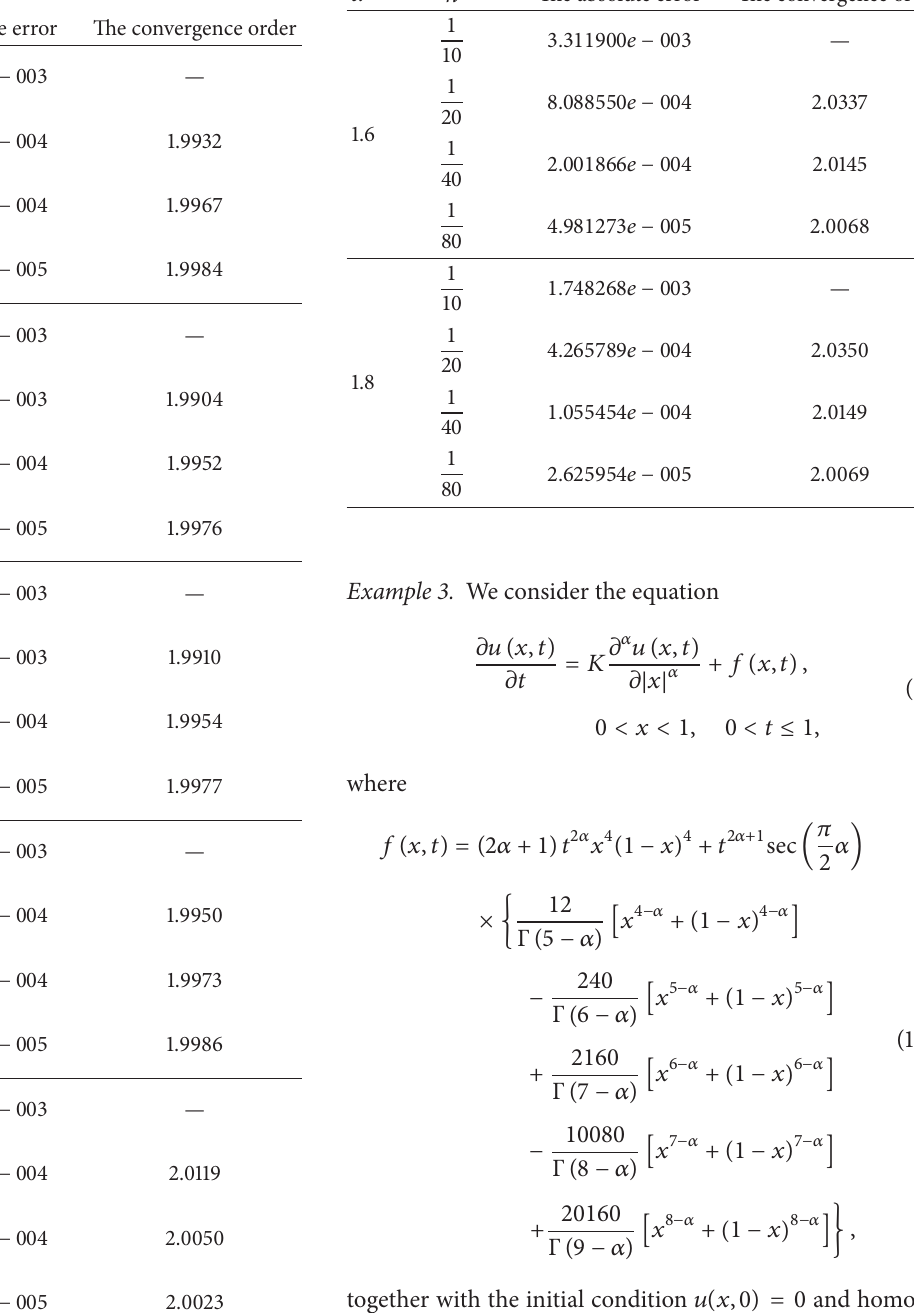
Table 3 lists the maximum error and time and space convergence orders for different 𝛼 . Numerical results show that the convergence order of the difference scheme (69) is 𝑂(𝜏 2 + ℎ 4 ) , which are in line with our theoretical analysis. Figures 1 and 2 show the comparison of the analytical and numerical solutions with 𝛼 = 1.1 at 𝑡 = 0.2 and 𝛼 = 1.9 at 𝑡 = 0.8 , respectively. It can be seen that the numerical solutions are in excellent agreement with the analytical